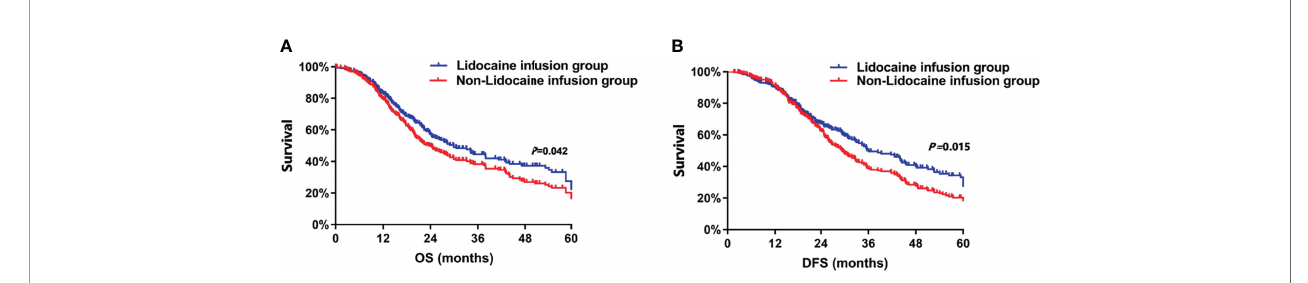
TABLE 2 | Univariate analysis of OS and DFS. Variables